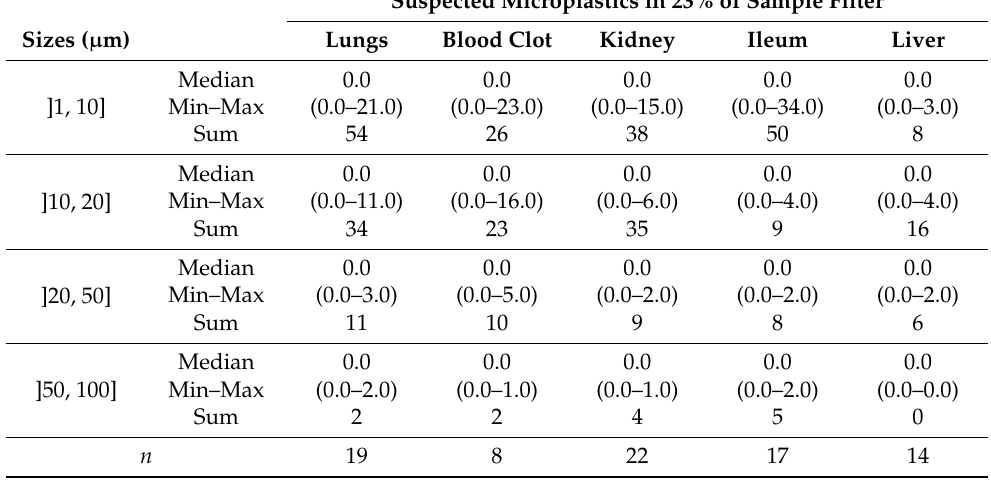
Table 2. Median, Min-Max, and Sum of the number of suspected microplastics found in 23% of the sample filter membrane after blank corrections by size categories, and number of individual samples containing suspected microplastics ( n ) per internal tissues of companion